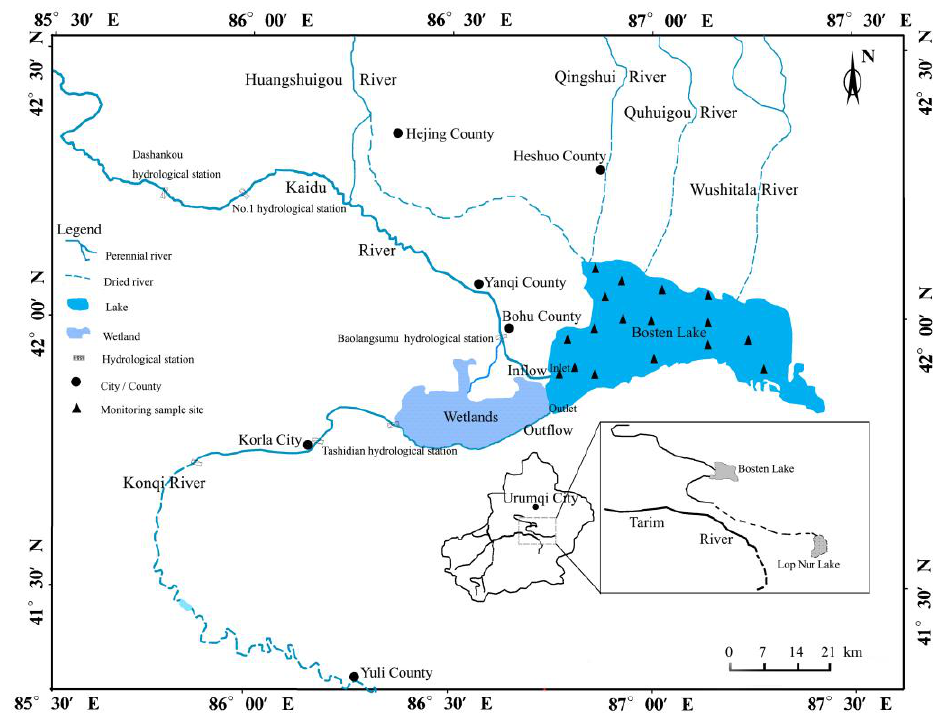
Figure 1. Illustration of the study area.